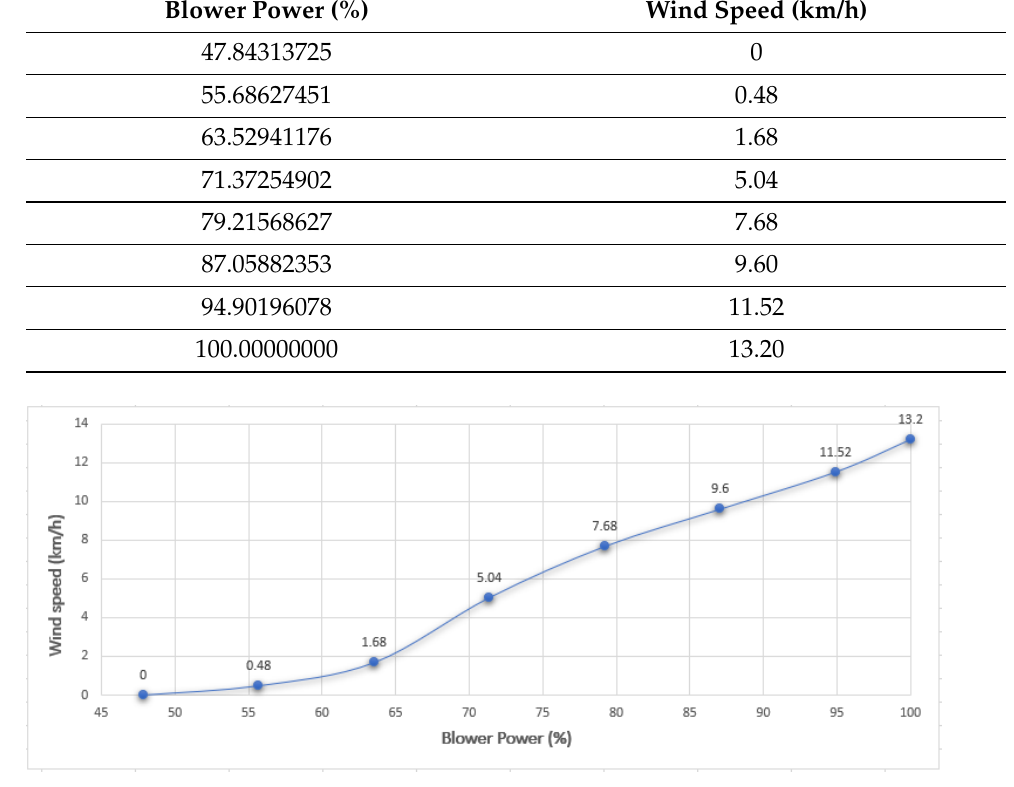
Figure 15. Instructional design: graphic level showing the blower power vs measured wind speed